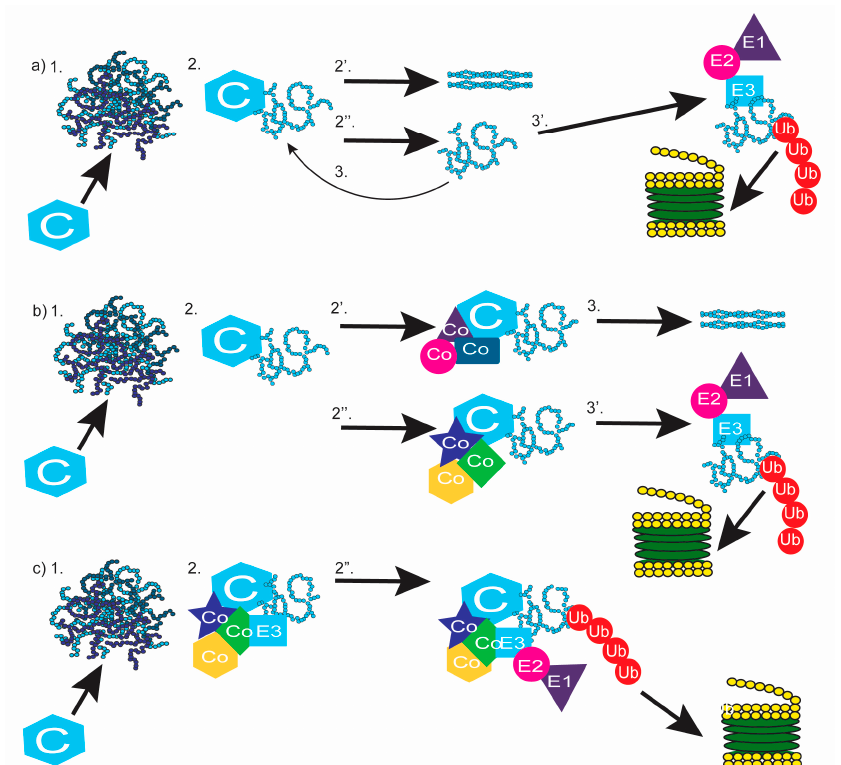
Figure 6. Models of chaperone and UPS cooperation in protein quality control. ( a ) Kinetic Model of Protein Triage. 1. Protein aggregate forms. Chaperones (C) are recruited. 2. Chaperones bind client protein and either succeeds in refolding (2 ′ ) or fail (2 ′′ ). 3. Misfolded proteins either rebinds chaperone or is targeted for degradation by the UPS; ( b ). cofactor mediated model of protein turnover. 1. Protein aggregate forms. Chaperones (C) are recruited. 2. Chaperone binds client protein and co-chaperones (co) are recruited and either promotes refolding of client protein (2 (cid:48) , 3. or degradation 2 (cid:48)(cid:48) , 3 (cid:48) ); ( c ) degradation complex model of protein triage. 1. Protein aggregate forms and Chaperones (C) are recruited. 2. Chaperone binds client protein and co-chaperones (co) are recruited, transforming for